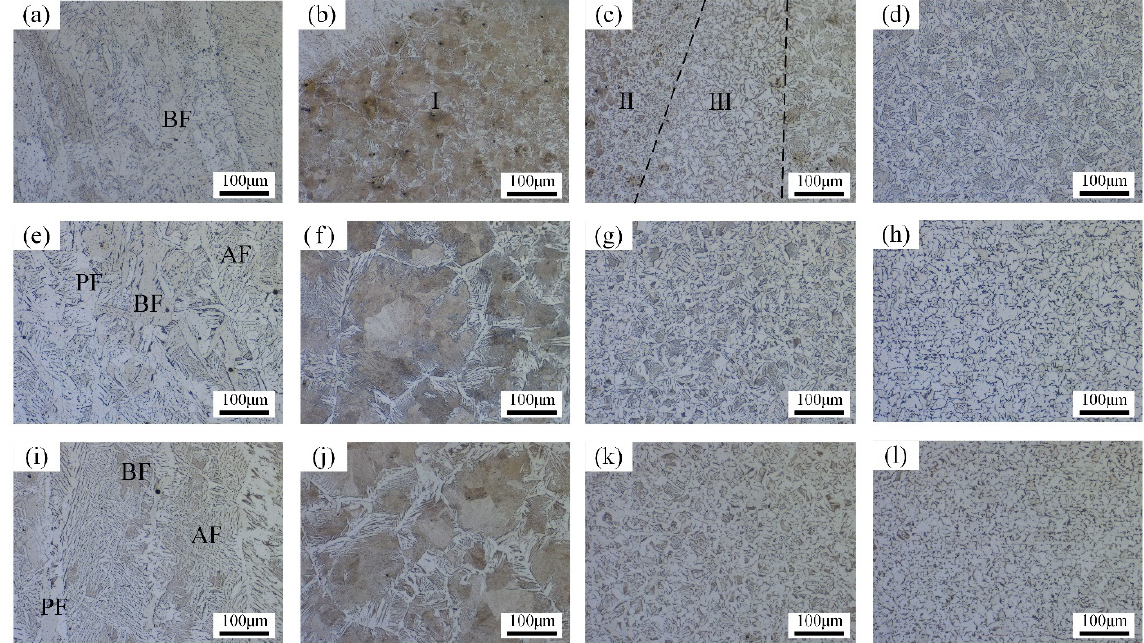
Figure 6. Microstructures of welds and HAZs. ( a , e , i ) weld metal for UWW, WG-USAW and EP-USAW; ( b , c ), HAZ of UWW; ( d ) base metal; ( f – h ) HAZ of WG-USAW; ( j – l ) HAZ of EP-USAW.